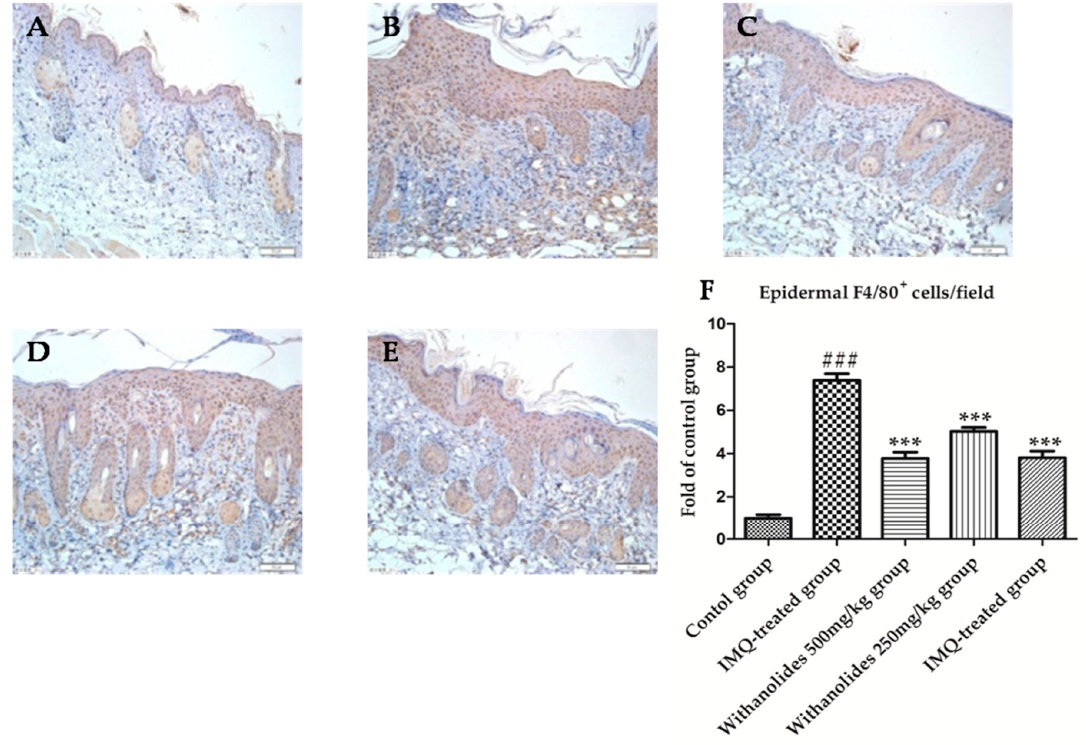
Figure 5. The psoriasis-like skin sections were strained by immunohistochemistry to evaluate F4 / 80 in five groups. (A) Control group. ( B ) IMQ-treated group. ( C ) Withanolides 500 mg / kg group. ( D ) Withanolides 250 mg / kg group. ( E ) MTX-treated group. ( F ) F4 / 80 positive cell / field (IF × 400). *** p < 0.001 vs. IMQ-treated group, ### p < 0.001 vs. control group.